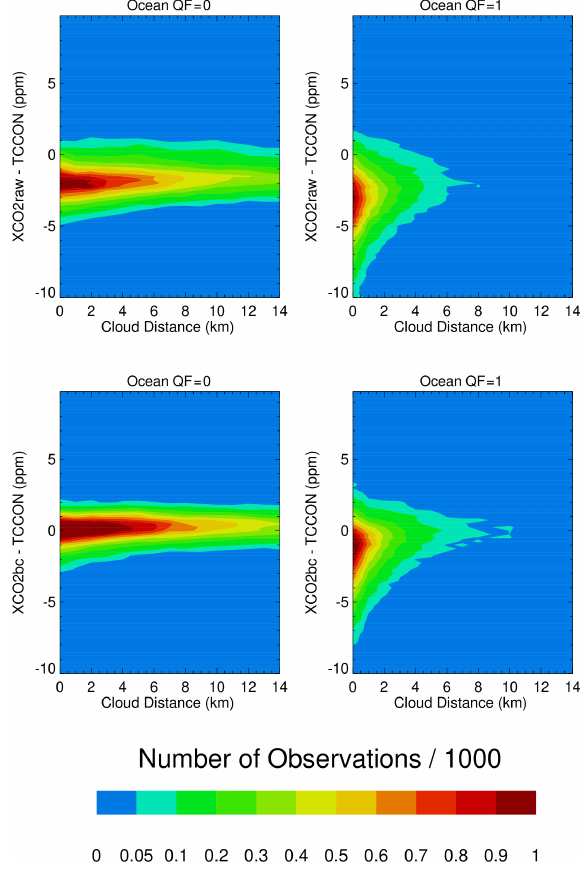
Figure 4. Contour maps of XCO2–TCCON over the ocean as a function of the nearest cloud distance for QF = 0 and QF = 1 XCO2raw and XCO2bc version 10 data. There is a very notice- able asymmetry (a tail of negative XCO2bc–TCCON) along verti- cal lines of the nearest cloud distance in the QF = 1 data, especially for small nearest cloud